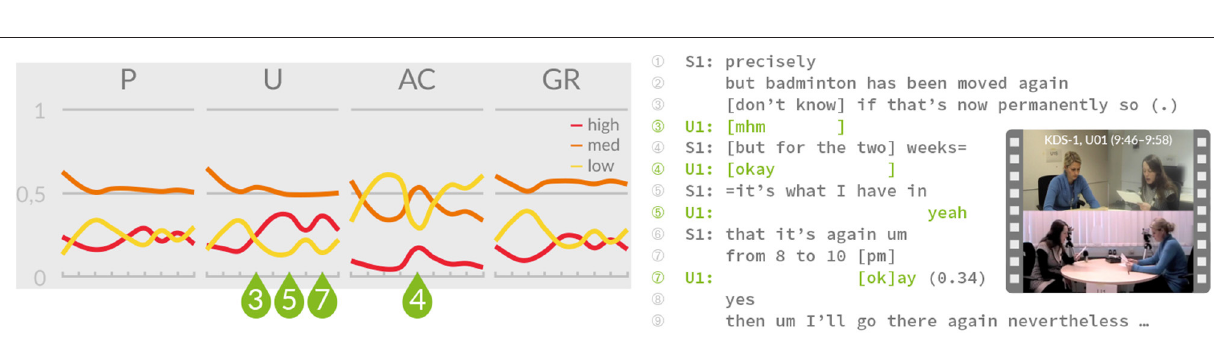
being more redundant or by repeating information that is already considered